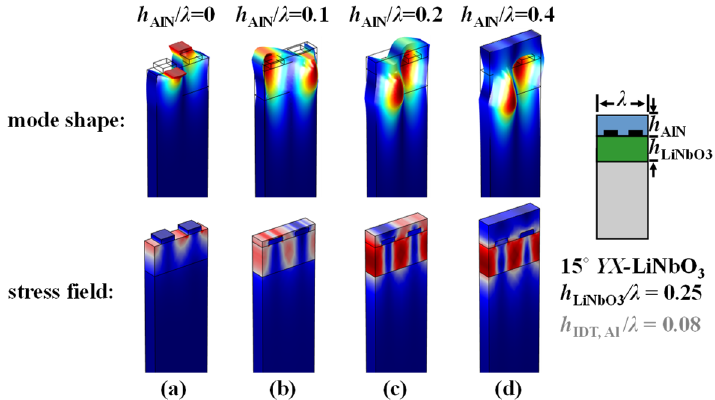
Figure 7. Trade-offs between the open-surface phase velocities v p,o and coupling coefficient k eff2 by varying AlN thickness for the SH wave propagating in AlN/ LiNbO 3 /Si based on ( a ) 15° YX -LiNbO 3 and ( b ) 30° YX -LiNbO 3 with h LiNbO3 / λ = 0.25 and h LiNbO3 / λ = 0.5.